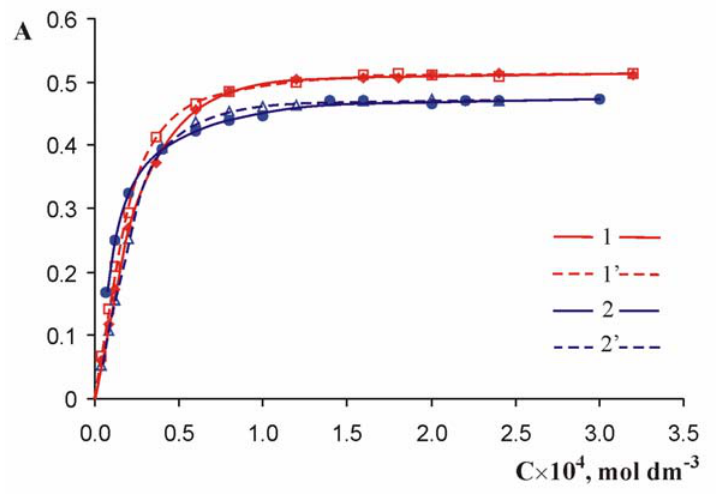
Fig. 3 Absorbance of extracts of V(V) vs. concentration of INT (curve 1), TAR (curves 1’ and 2’) and NBT (curve 2) plots: 1 - C pH=4.75; 1’ - C =2x10 − 5 mol l − 1 , C V ( V ) mol l − 1 , C =2x10 − 4 mol l − 1 , pH=5.5; 2’ - C TAR l − 1 ,